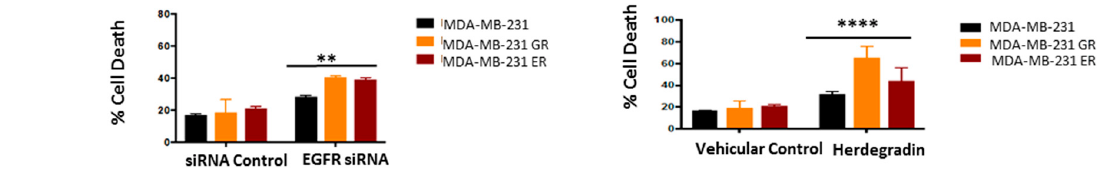
Figure 6. Targeted reduction of EGFR increases cytotoxicity in EGFR-TKI-resistant cells. ( A ) GR and ER cells were seeded on 12-well plates along with respective non-treated parental controls. Once the cells were 80% confluent, the cells were grouped into three experimental treatment groups: EGFR knockdown group transfected with EGFR specific siRNA compared against EGFR siRNA control, and cells treated with EGFR downregulating peptide-herdegradin compared against vehicular control. All the cells were treated for 72 h in serum-free media. The maximum tolerable concentrations of herdegradin were used (PC3, PC3ER, PC3GR: 2.5 µ m, Du145, Du145 GR, Du145 ER: 20 µ M, A549, A549ER, A549GR: 20 µ M, MDA-MB-231, MDA-MB-231 GR, MDA-MB-231 ER: 20 µ M) for treatment above which complete cell death was induced in both non-treated parental controls and resistant cells. Cell lysates following treatment were collected and Western blot analysis was conducted to examine EGFR expression; ( B ) GR and ER cells were seeded on 6-well plates along with non-treated parental controls. Once the cells were 80% confluent, the cells were assigned to three experimental groups: EGFR knockdown group transfected with EGFR specific SiRNA compared against EGFR siRNA control, and cells treated with EGFR downregulating peptide-herdegradin compared against the vehicular control. All the cells were treated for 72 h in serum-free media, following which percent cell death was calculated for each treatment group. The concentration of peptide herdegradin varied according to cell types (PC3, PC3ER, PC3GR: 2.5 µ m, Du145, Du145 GR, Du145 ER: 20 µ M, A549, A549ER, A549GR: 20 µ M, MDA-MB-231, MDA-MB-231 GR, MDA-MB-231 ER: 20 µ M). Equal volumes of cell suspension were incubated with 0.4% trypan blue to obtain 1:2 dilution. Cells were counted using hematocytometer and percent cell death calculated. Results were triplicated ± SD and were pooled into treatment groups. One-way ANOVA and Tukey’s multiple comparison test was used for statistical analyses, ** p < 0.001, **** p <